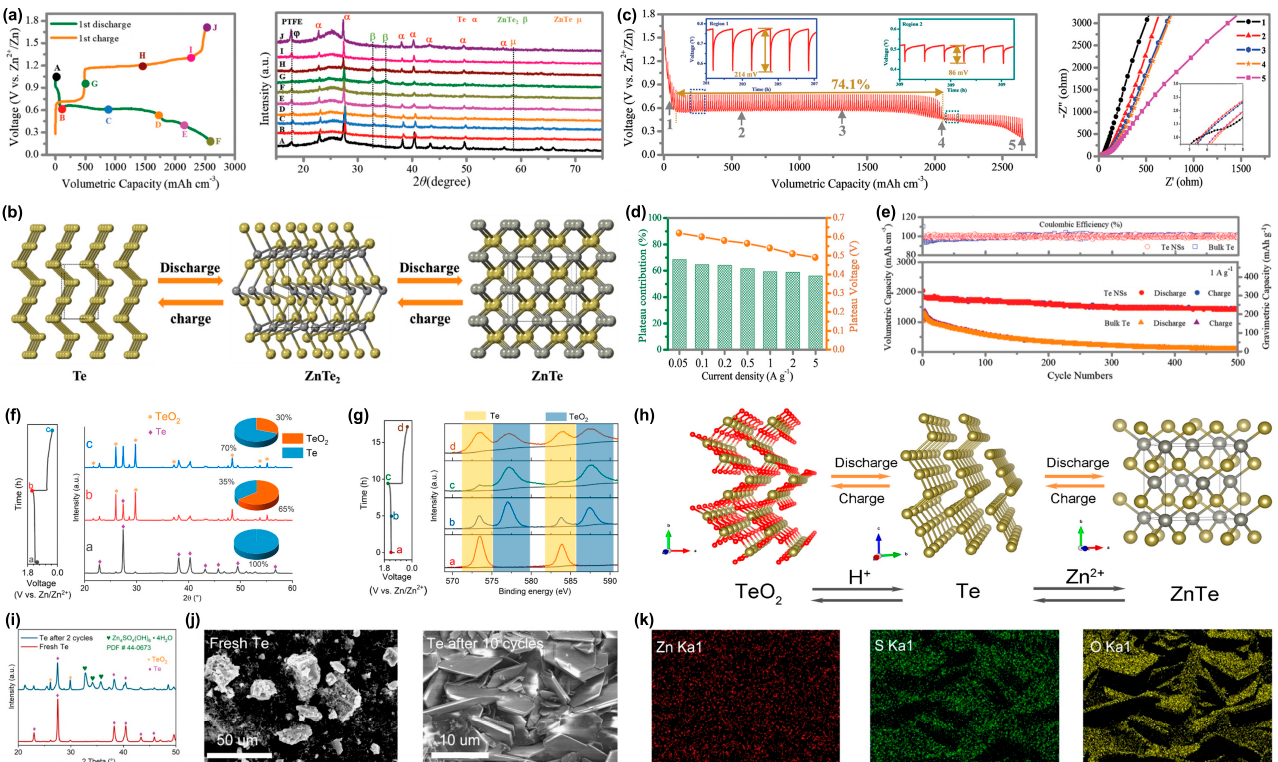
Figure 13. ( a ) GCD curve at 0.05 A g − 1 and corresponding ex situ XRD patterns; ( b ) schematic of phase transformation of the Te cathode in AZTeBs; ( c ) galvanostatic intermittent titration technique (GITT) profiles of AZTeBs and corresponding electrochemical impedance spectroscopy (EIS) curves at different discharge states; ( d ) plateau contribution and voltage plateau at different current densities; ( e ) cycling stability of AZTeBs (reproduced with permission from Ref. [66]. Copyright 2020, Wiley- VCH). GCD curve at 50 mA g − 1 and corresponding ( f ) ex situ XRD patterns and ( g ) ex situ XPS spectra (Te 3d 3/2 and Te 3d 5/2 ); ( h ) schematic of the reaction mechanism; ( i ) XRD patterns and ( j ) SEM images of fresh Te and Te after cycles; ( k ) EDS mappings (Zn, S, and O) of Te after cycles (reproduced with permission from Ref. [104]. Copyright 2021, American Chemical